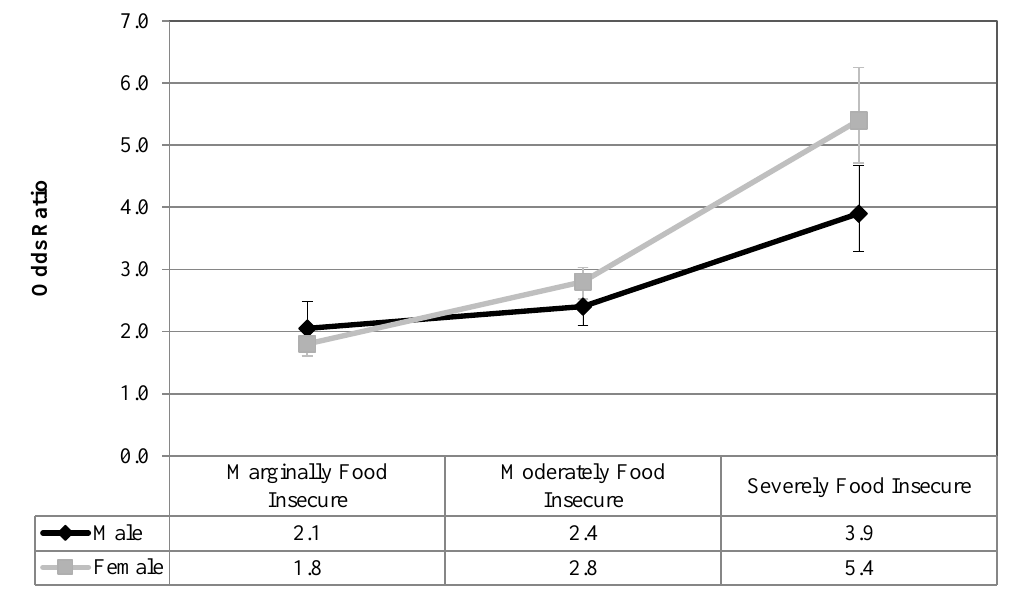
Figure 3. Odds ratio of reporting mood disorders for each level of household food insecurity stratified by sex, compared with food secure; results from reduced binary logistic regression.